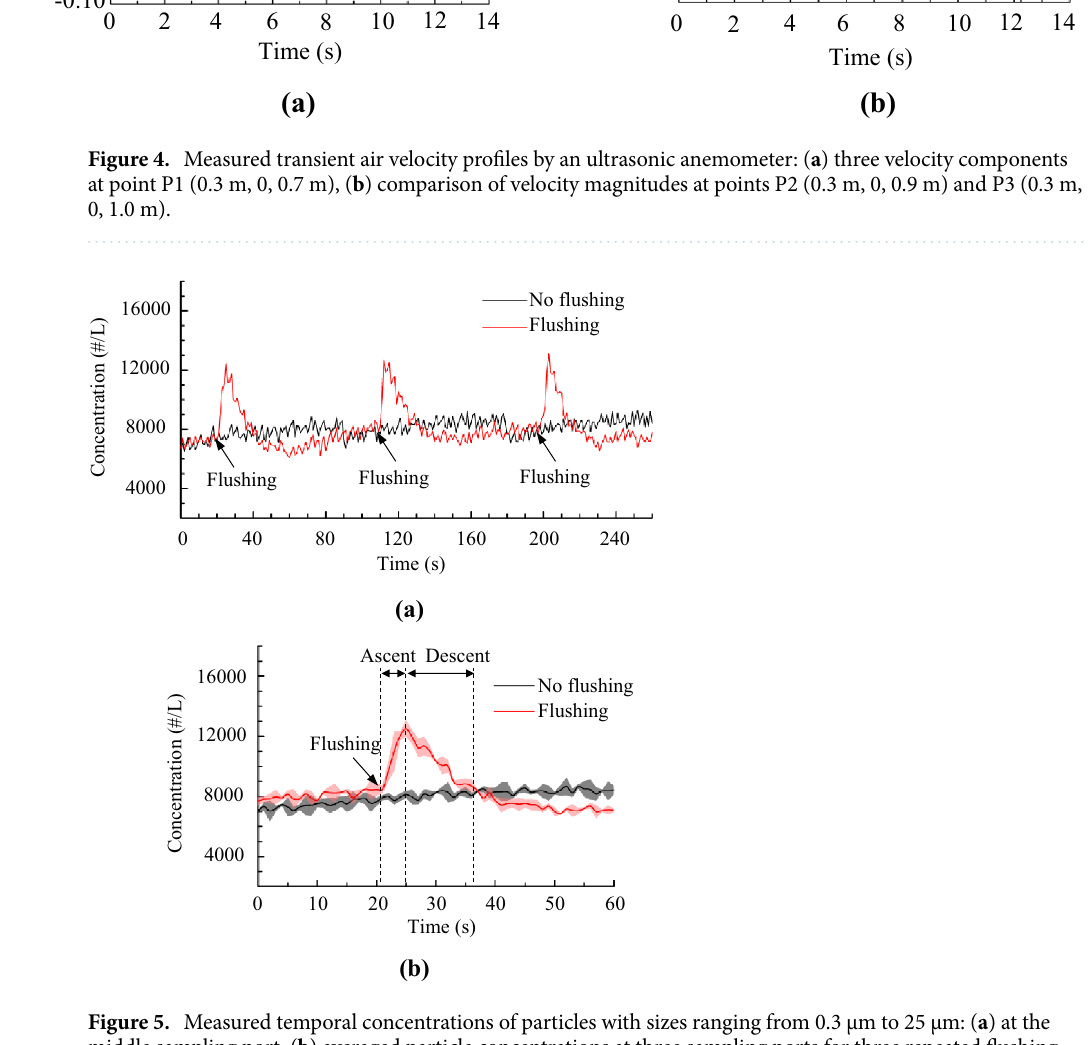
Figure 5. Measured temporal concentrations of particles with sizes ranging from 0.3 μm to 25 μm: ( a ) at the middle sampling port, ( b ) averaged particle concentrations at three sampling ports for three repeated flushing processes, where the shaded bands represent standard